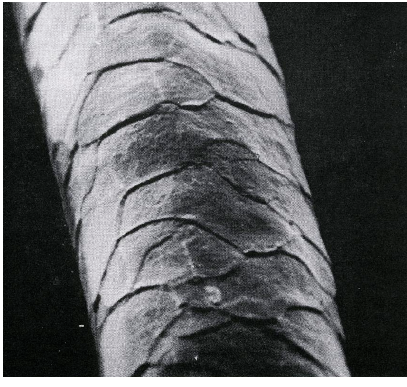
Figure 23. Hair cuticles in hair that has been pulled from the scalp.